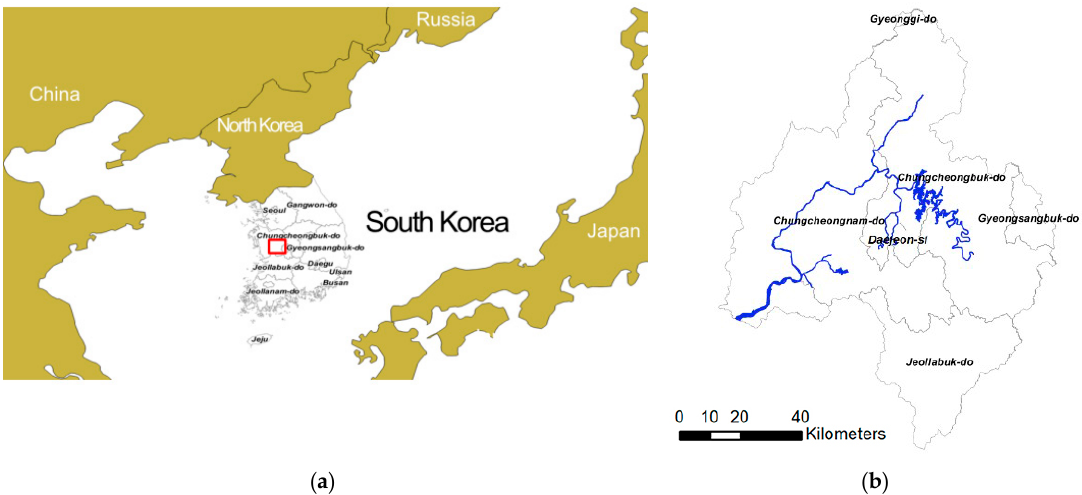
Figure 2. Location of the Geum River Basin. ( a ) Korean Peninsula; ( b ) Geum River Basin.